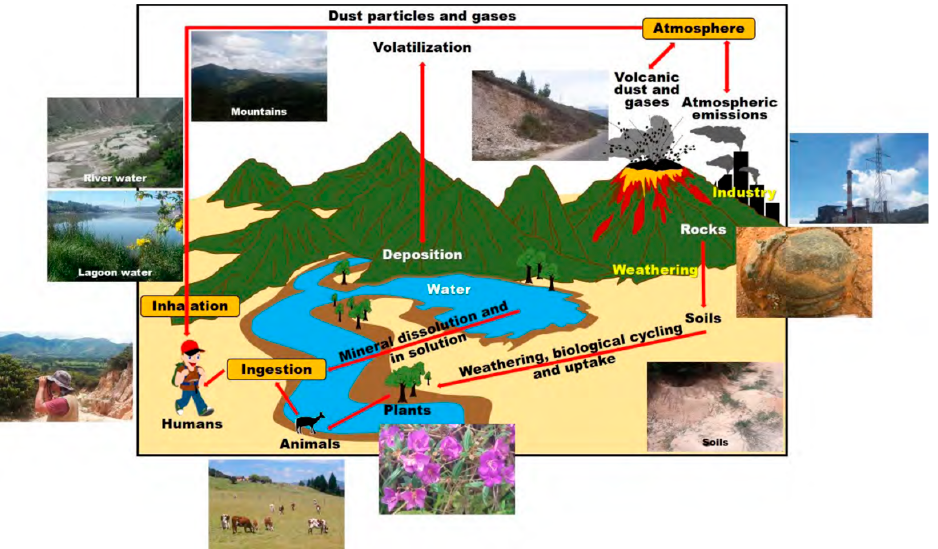
Figure 10. Schematic representation of the relationship between the biosphere and the geosphere. Reproduced with permission from the authors [186].